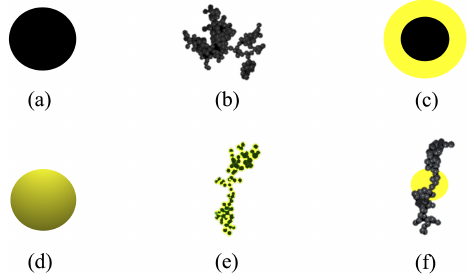
Figure 1. Morphological representations of black carbon used in this study: (a) sphere, (b) aggregate, (c) coated sphere, (d) homoge- neously mixed sphere, (e) coated aggregate, and (f) aggregate partly enclosed in